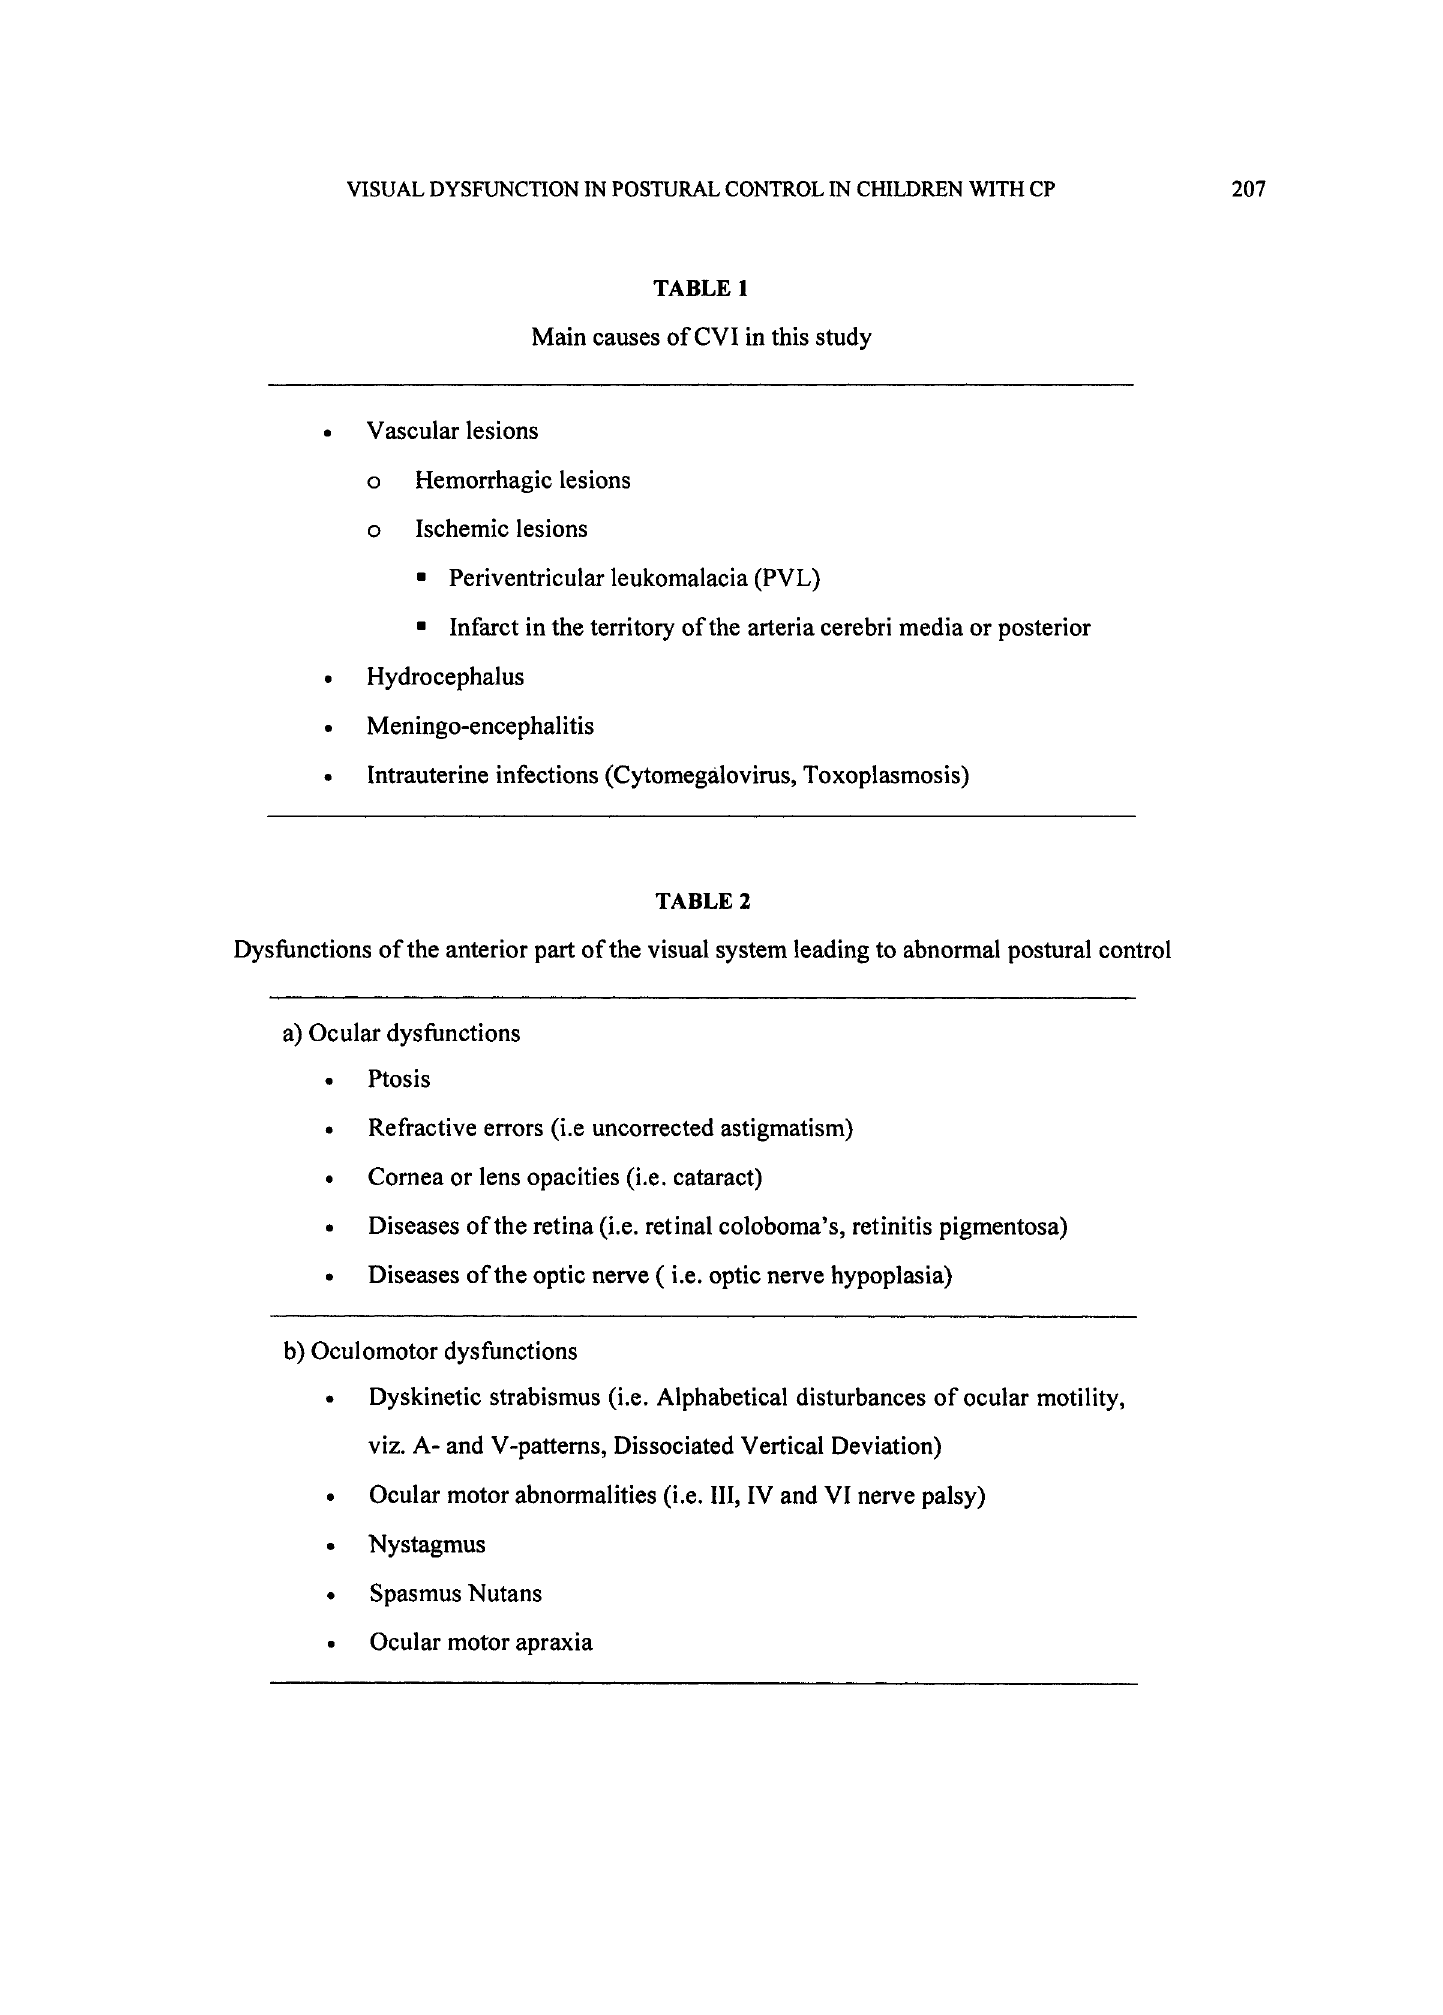
Main causes of CVI in this study